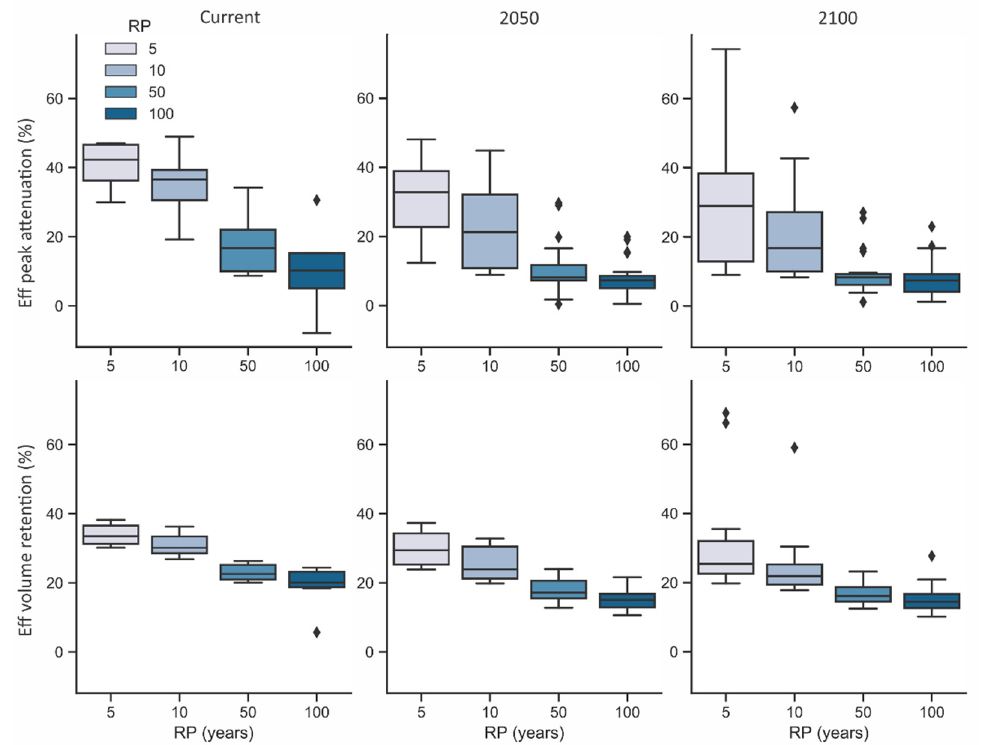
Figure 6. LID practices efficiency in peak attenuation and volume reduction for the current and future scenarios. The black rhombuses are the data outliers.